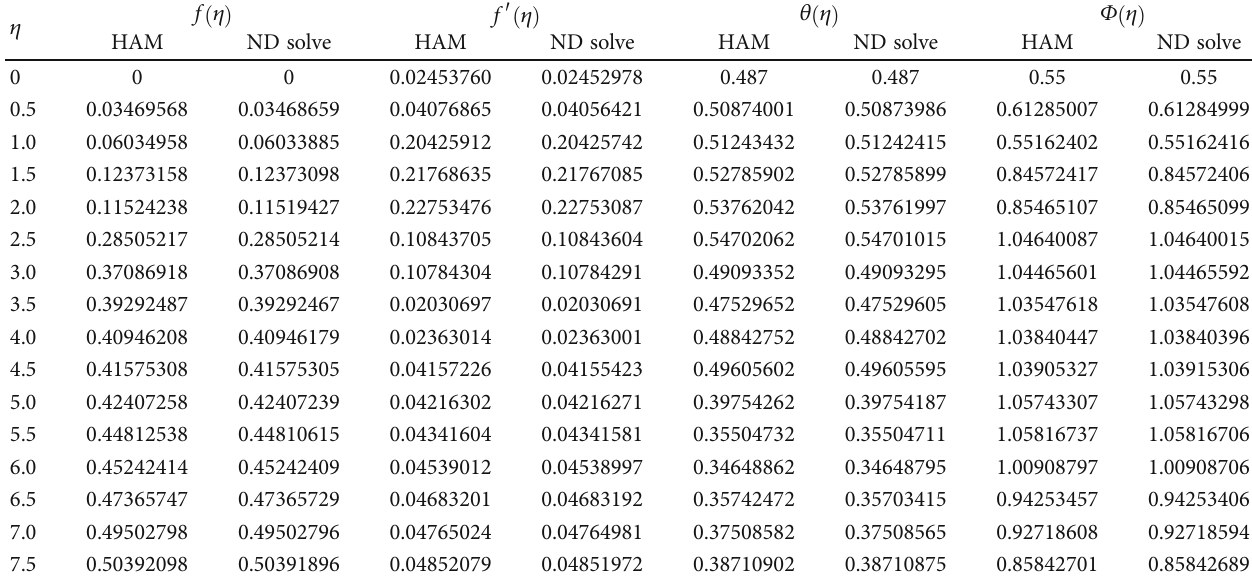
= 0 : 25, ϕ = 0 : 25, ε = 0 : 3, N 1 2